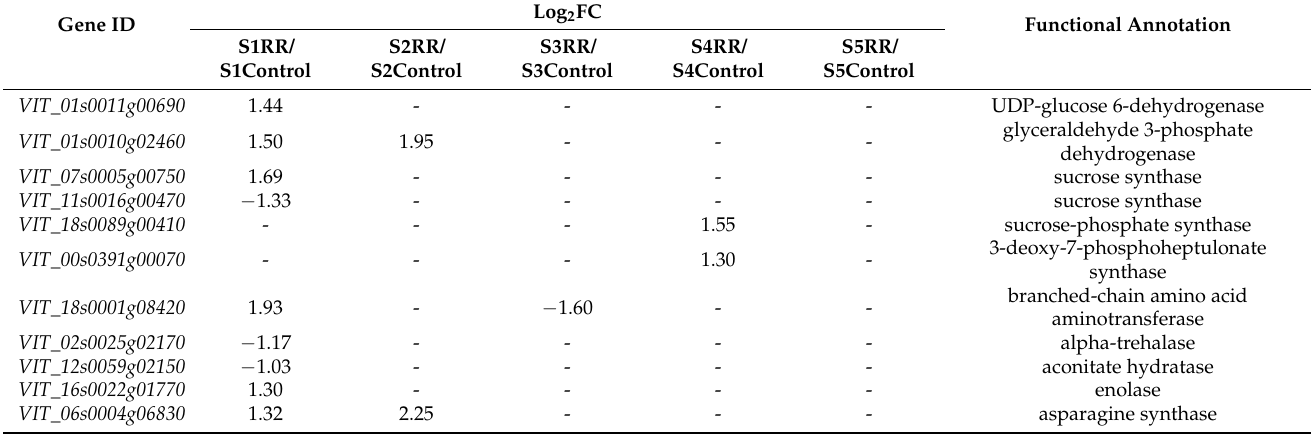
Table 2. Differentially expressed genes in the primary metabolic pathways under RR treatment